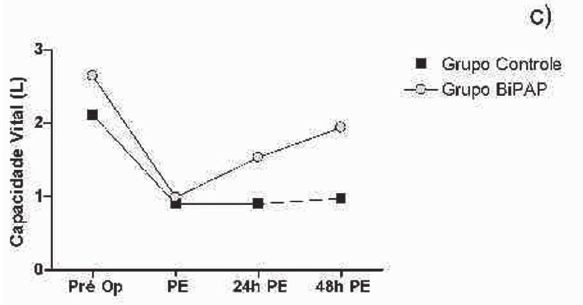
Fig. 1 – A: Distribuição representativa das alterações do Volume Minuto no Pré-Operatório, pós-extubação imediata, 24ª e 48ª horas pós-extubação, em média, nos grupos Controle e BiPAP (P<0,001 intragrupos; P=0,250 intergrupos); B: Distribuição representativa das alterações do Volume Corrente no pré-operatório, pós- extubação imediata, 24 e 48 horas pós-extubação em média, nos grupos (P<0,001 intragrupos; P=0,250 intergrupos); C: Distribuição representativa das alterações da Capacidade Vital no pré-operatório, pós-extubação imediata, 24 e 48 horas pós- extubação em média, nos grupos Controle e BiPAP (P<0,001 intragrupos; P=0,15 intergrupos). Pré-op= Pré-operatório e